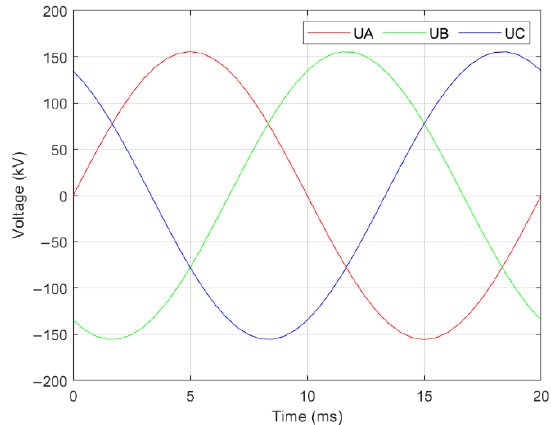
Figure 19. Wire voltage changes over time.